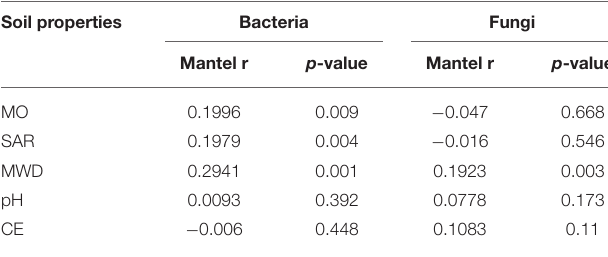
TABLE 4 | Mantel correlation between bacteria/archaea and fungi with soil physicochemical properties.